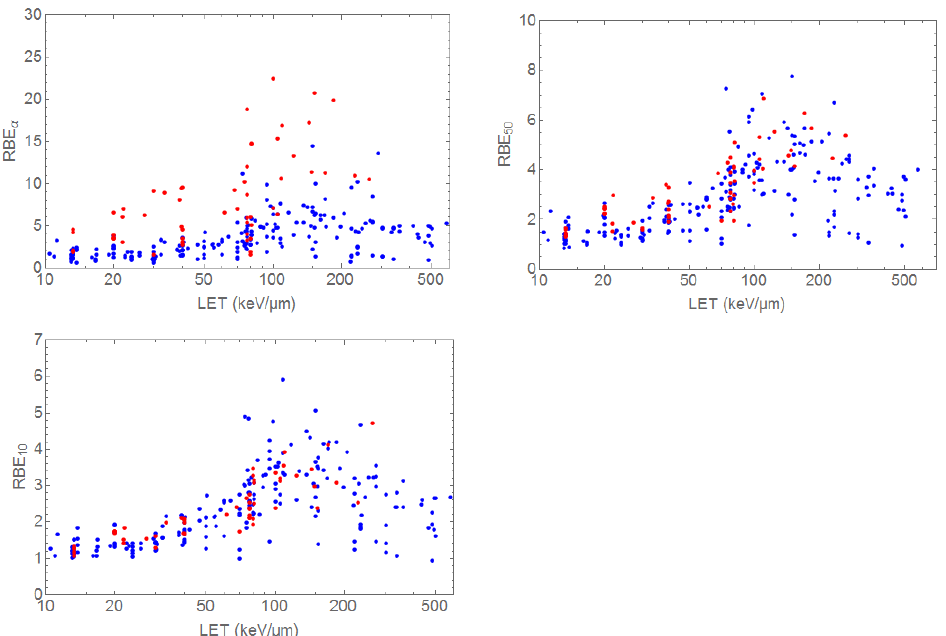
Figure 8. RBE of C-ions from the PIDE database. The 3 panels represent the RBE  , RBE 50 , and RBE 10 radioresistant (red; α / β < 4 Gy) and radiosensitive (blu; α / β > 4 Gy) cells. Plot courtesy of Dr. Thomas for radioresistant (red;  < 4 Gy) and radiosensitive (blu;  > 4 Gy) cells. Plot courtesy of Dr. Friedrich, Thomas Friedrich, GSI.